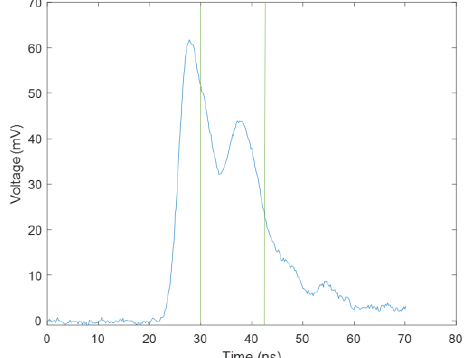
Fig. 7. Timing window for neutron double scatter candidates. The peak of the secondary scatter feature must appear between 2 and 12 ns after the primary